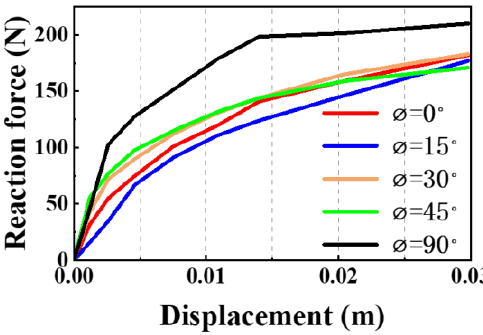
Figure 21. Bearing capacity – displacement curve at different stress angles.